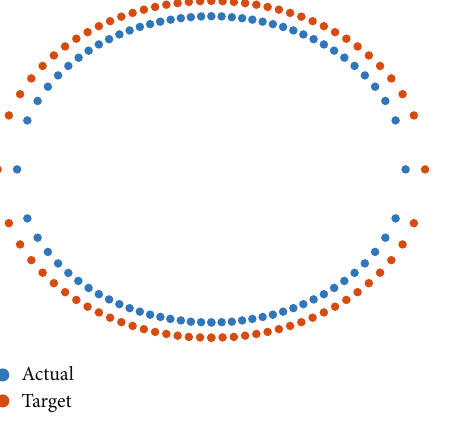
Figure 5: Schematic illustration of scaling step. Table. 1: The design space and initial value.